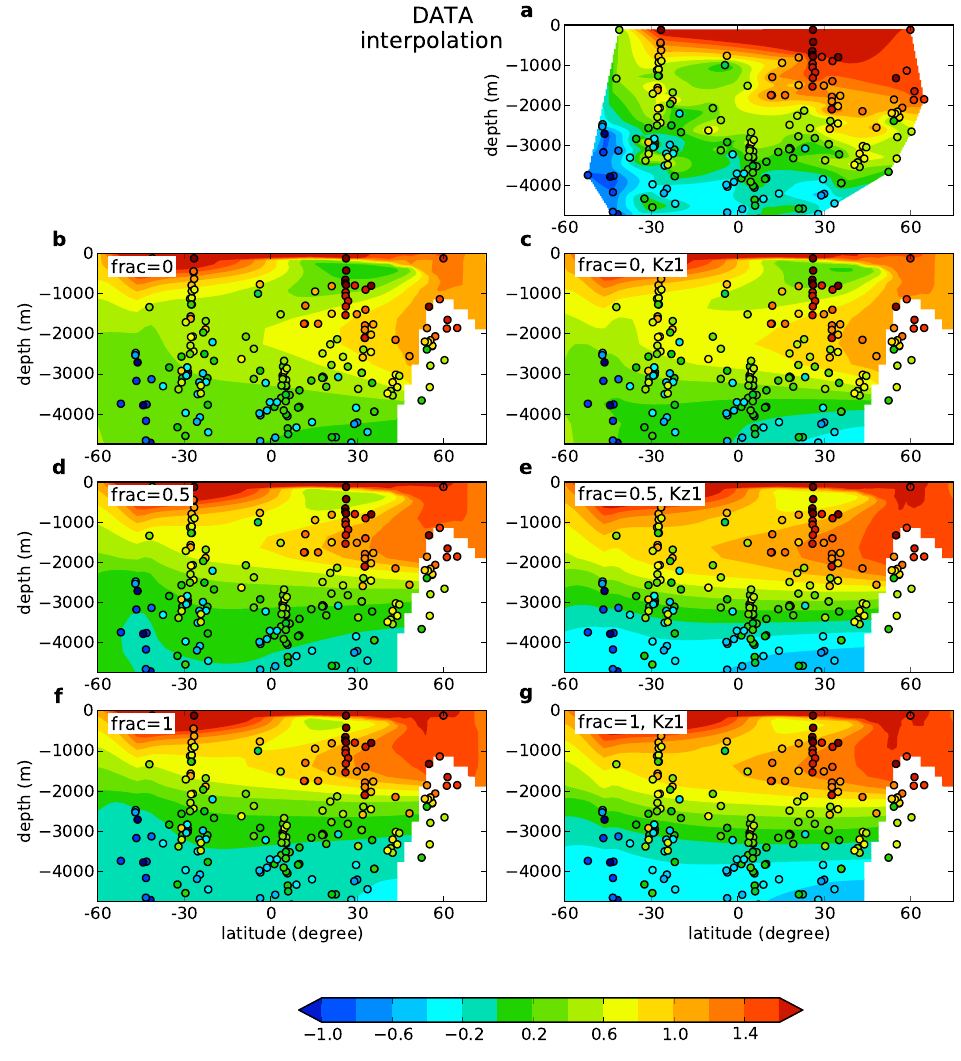
Fig. 9. δ 13 C (‰) distribution in the Atlantic. The dots represent the LGM data (Curry and Oppo, 2005; K¨ohler and Bintanja, 2008). (a) Interpolation of the data. (b) , (c) , (d) , (e) , (f) , (g) Modelled δ 13 C distribution: (b), (d), (f) with the standard diffusion profile Kz0 (Fig. 7); (c), (e), (g) with the low diffusion profile Kz1 (Fig. 7). (b), (c) frac =0 (no impact of brines), (d), (e) frac =0.5 (medium impact of brines), (f), (g) frac =1 (maximum impact of brines).